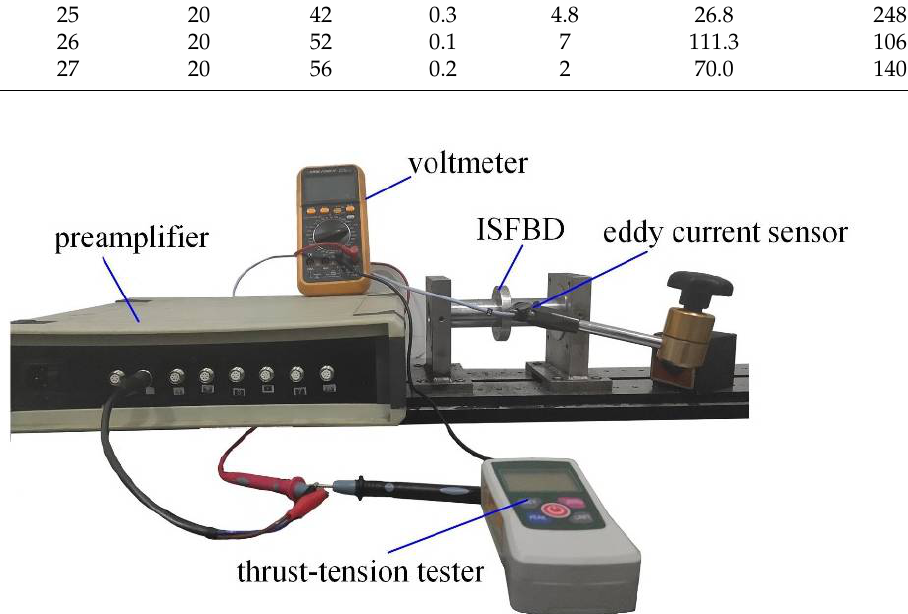
Figure 8. Stiffness test rig.